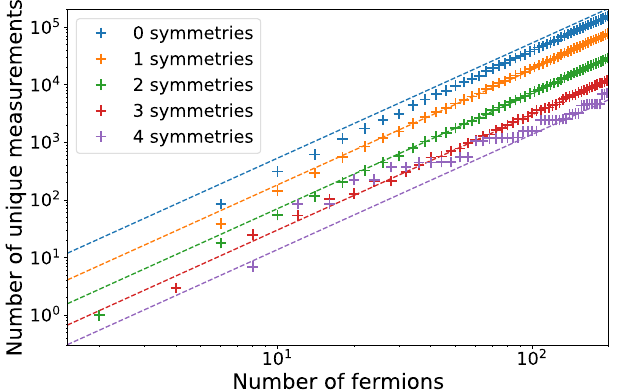
FIG. 1. Scaling of our Majorana partitioning scheme in the presence of between 0 and 4 symmetry constraints on the system. Dashed lines are from Eq.